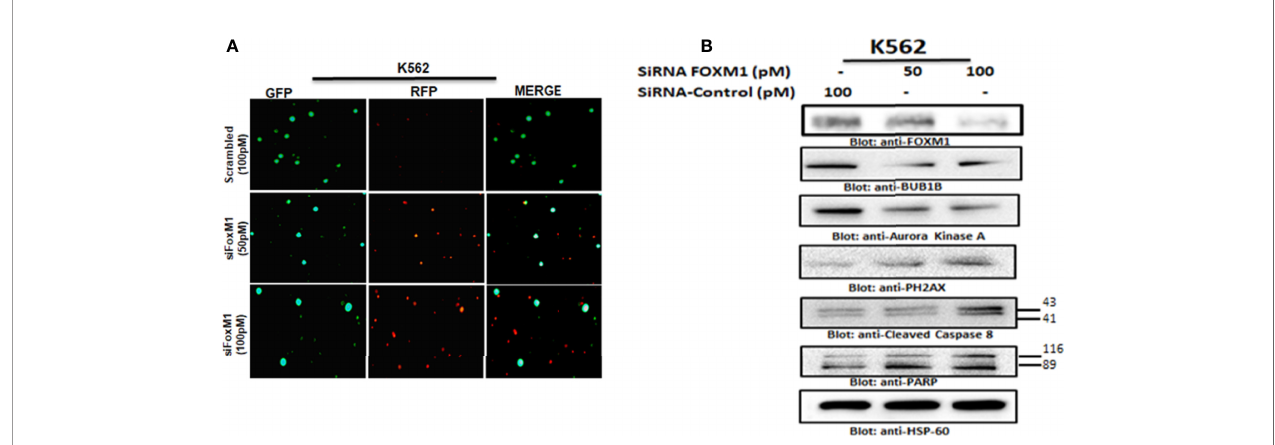
FIGURE 6 | Gene silencing of FOXM1 suppressed BUB1B expression. (A) K562 cells were transfected with control (100 pM) and FOXM1 siRNA (50 and 100 pM) as indicated. After 48 hours of transfection Live and dead assay was performed for detection of live and dead cells after FOXM1 knockdown. (B) K562 cells were transfected with control (100 pM) and FOXM1 siRNA (50 and 100 pM) as indicated in Materials and Methods. Immunoblot analysis of K562 cells transfected with control (100 pM) and FOXM1 siRNA (50 and 100 pM). Cells were lysed, and an equal amount of proteins for each sample were loaded onto the SDS-polyacrylamide gel. Membranes were blotted against FOXM1, BUB1B, Aurora Kinase A, p-H2AX, Cleaved caspase-8, PARP and